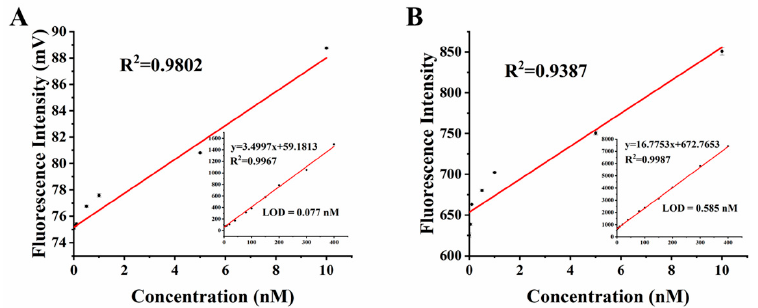
Figure 8. Linearity of the fluorescence signal with the concentration of fluorescein sodium solution: ( A ) the results from the detector in this paper; ( B ) the results from the spectrofluorophotometer.